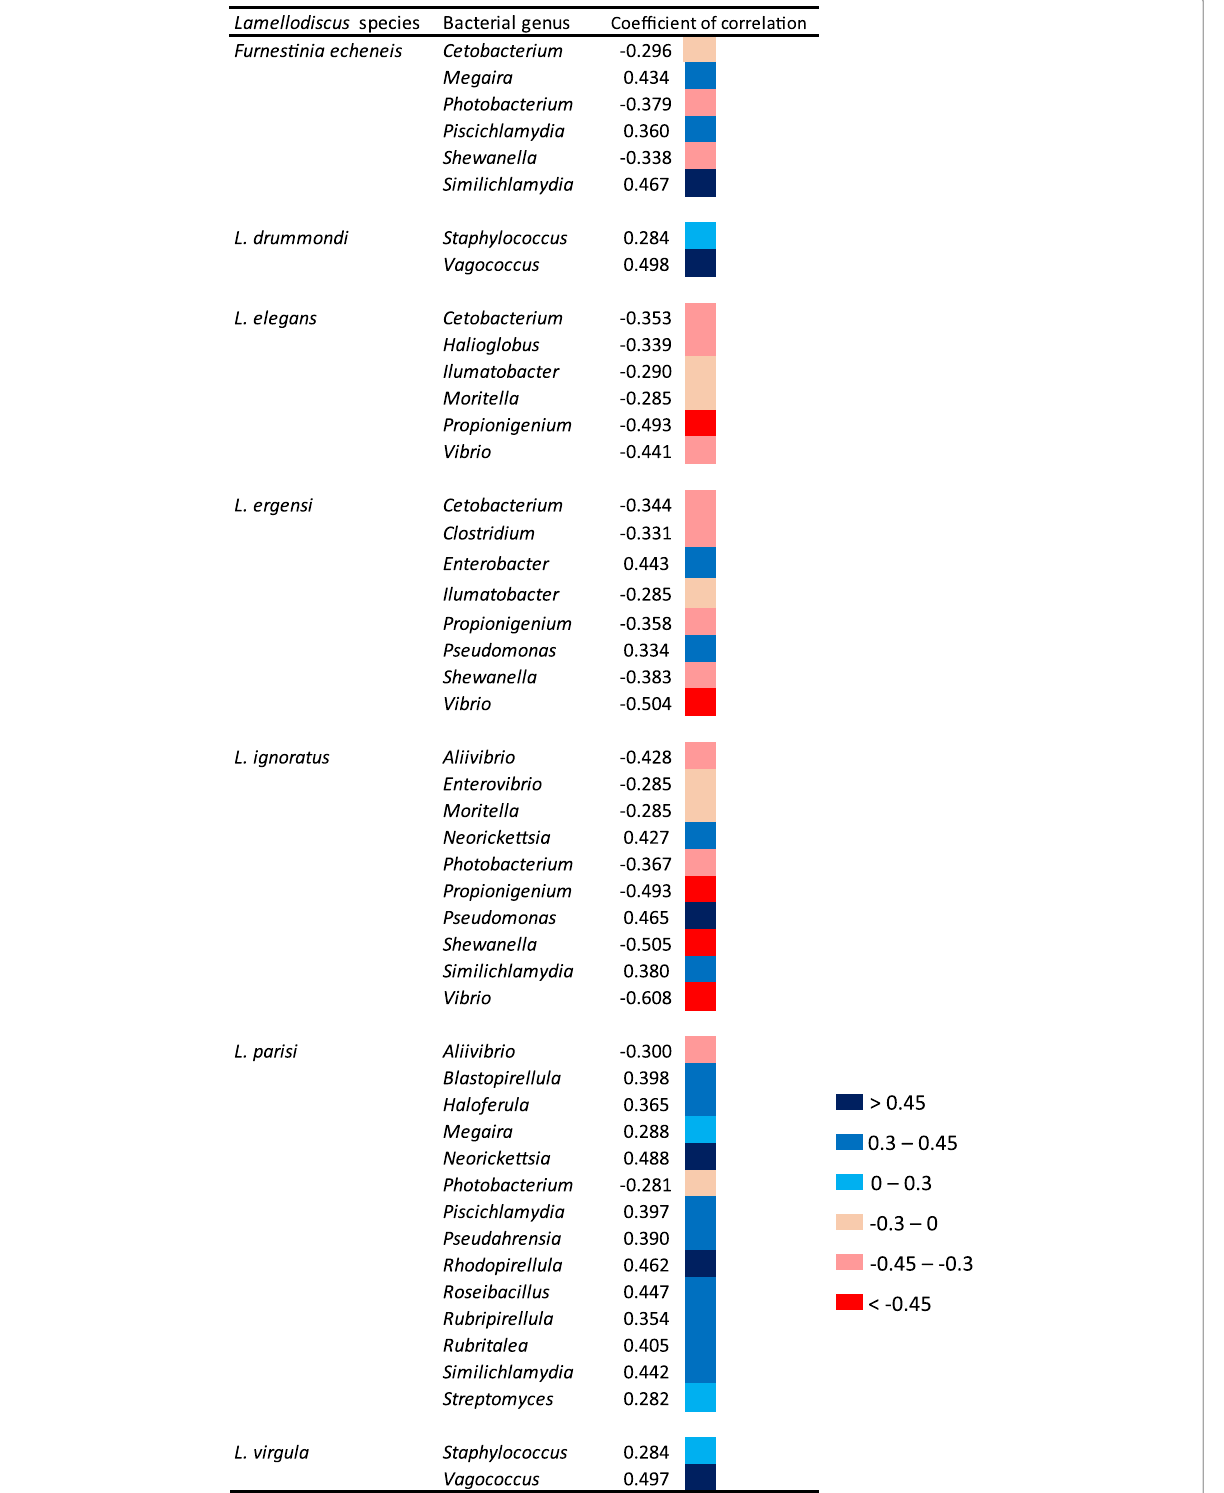
Fig. 6 Significant Spearman correlation coefficients between the abundances of Lamellodiscus and bacterial genus in fish gills. The color of each cell represents positive (blue) and negative (red) correlations